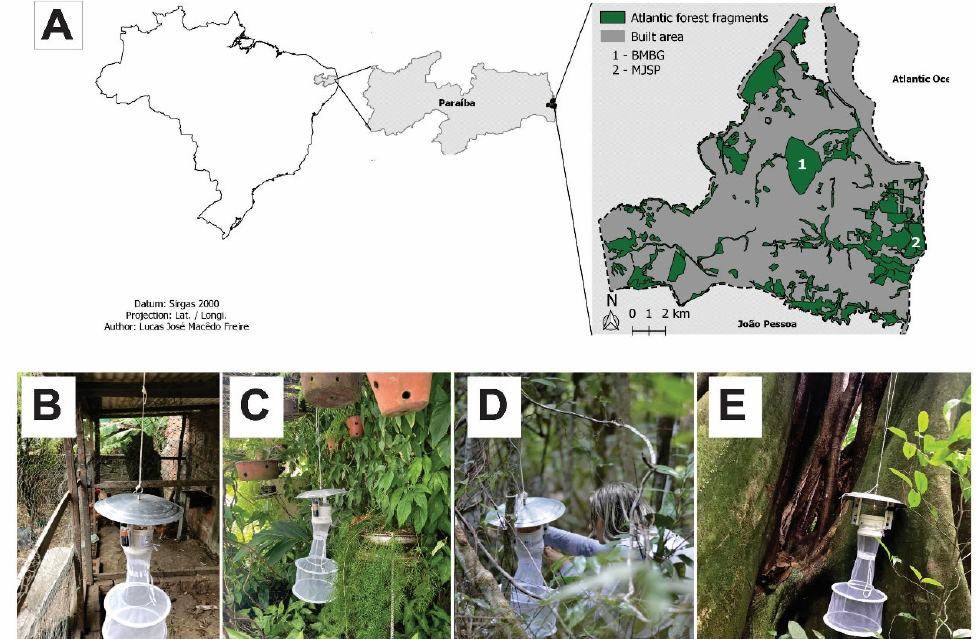
Figure 1. ( A ) Map of the municipality of João Pessoa showing the forest and built areas including two forest fragments studied (points 1 and 2); ( B ) Point at MJSP; ( C ) Point at BMBG; ( D , E ) Points in the built area.